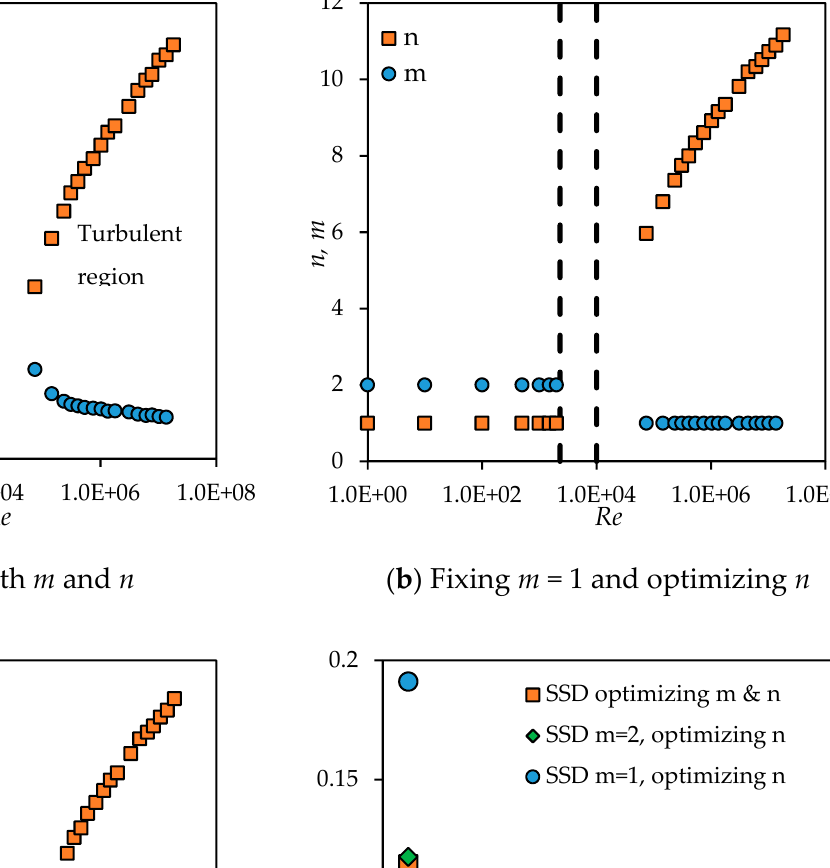
Figure 8. Comparisons between the measured velocity profiles and those calculated based on the optimization of one or two of the parameters (i.e., m and n ) at different Re . ( a ) Re=7.43 x 10 4 , ( b ) Re=1.4458 x 10 5 , ( c ) Re=1.3462 x 10 6 , and ( d ) Re=1.831 x 10 7